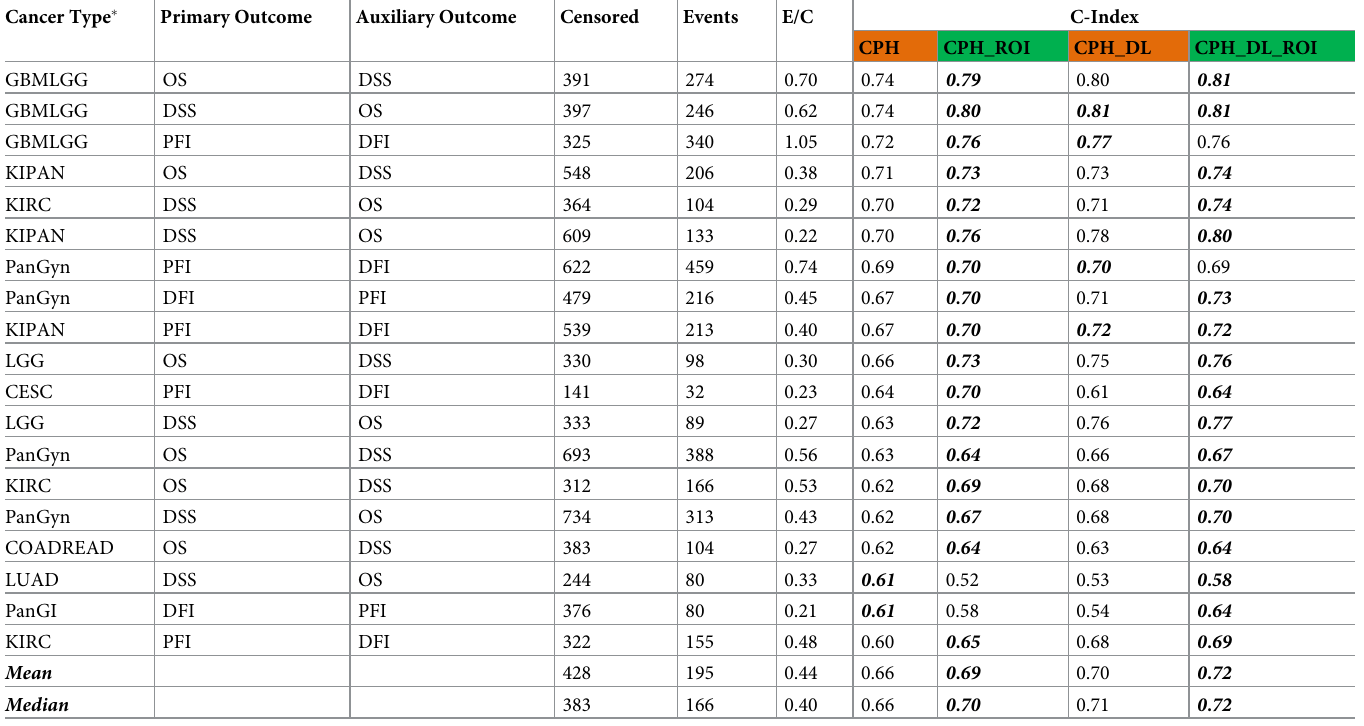
Table 1. TTE prediction model performance comparison on TCGA data. Cancer Type